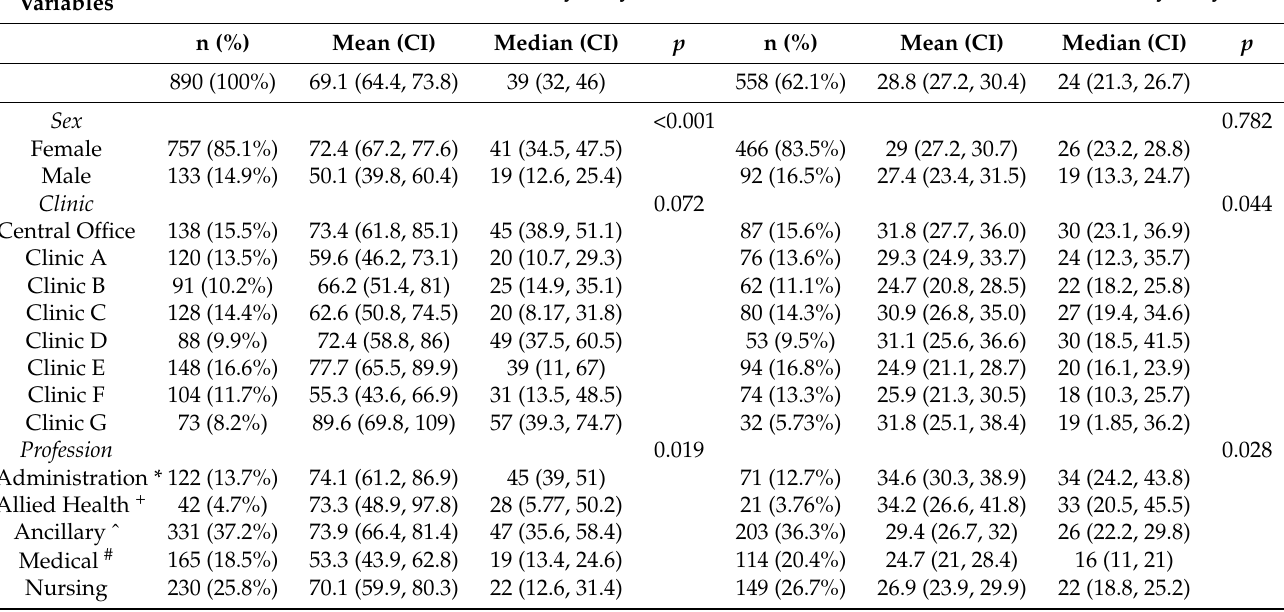
Table 1. Mean and median of delay in COVID-19 1st dose and booster uptake among HCW.